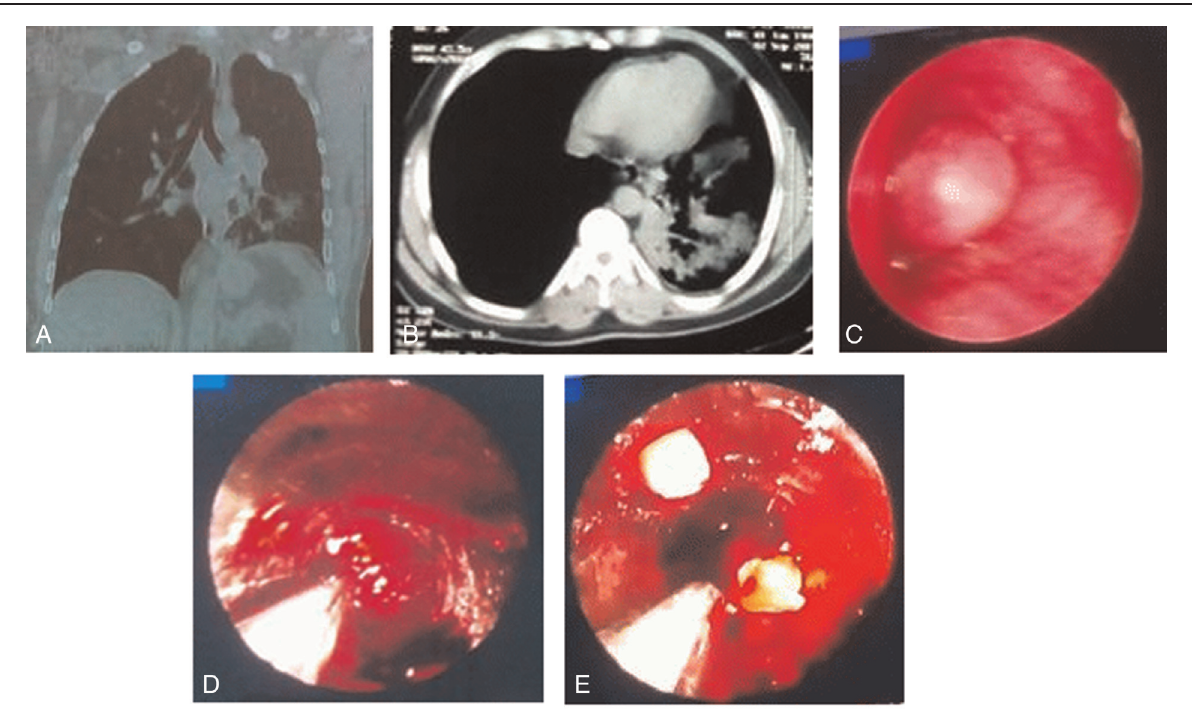
(a) Reconstructive coronal CT chest view showing left main obstruction with endobronchial lesion. (b) CT chest mediastinal view showing left lower lobe collapse and necrotic tissue within. (c) Bronchoscopic view of left main bronchus with an obstructing mass. (d) Bronchoscopic view (rigid) during cauterization of the lesion then bronchoscopic coring. (e) Bronchoscopic view after restoration of more than 50% of the airway